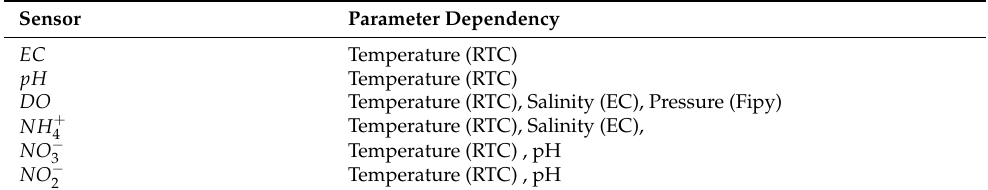
Table 6. Sensor’s Parameter dependencies for